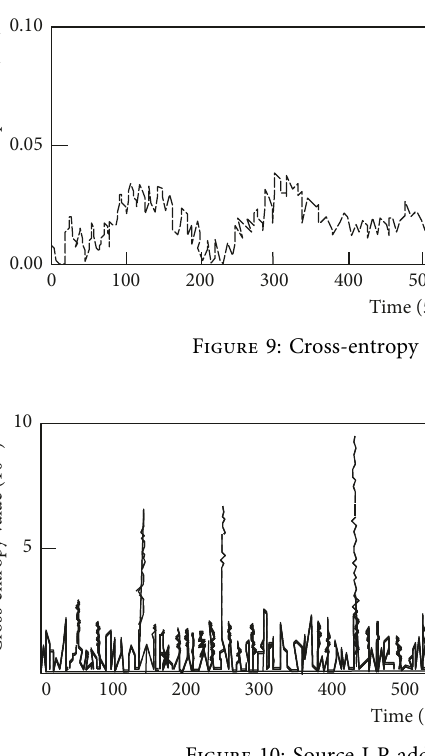
Figure 10: Source I P address cross